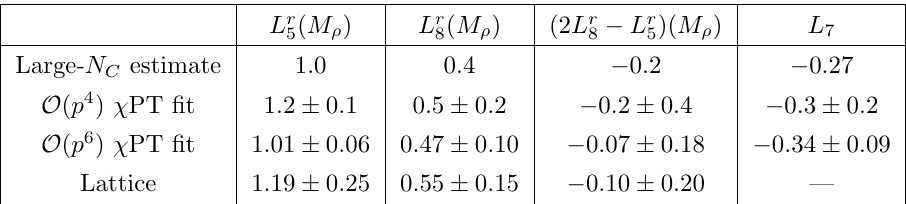
Table 2 . Comparison of the large- N C estimates for the relevant strong LECs of O ( p 4 ) [55] with the values extracted from O ( p 4 ) and O ( p 6 ) (cid:31) PT (cid:12)ts [67] and the lattice results [92, 122]. All numbers are given in units of 10 (cid:0) 3